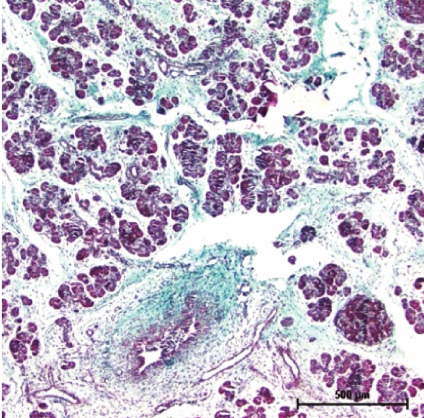
Figure 7: 32 cm CVRL (146 days) showing collagen fibers in connective tissue. Masson’s trichrome ×